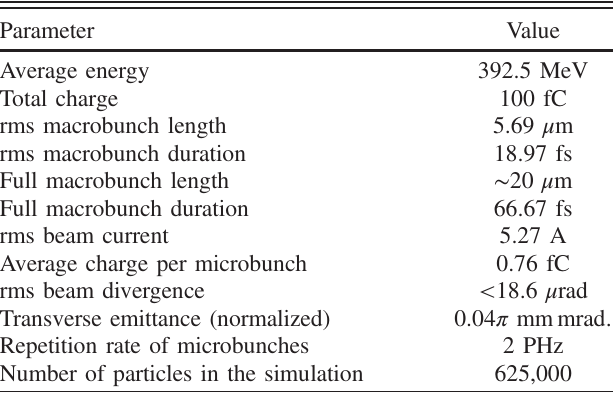
TABLE II. Parameters of the output electron beam.